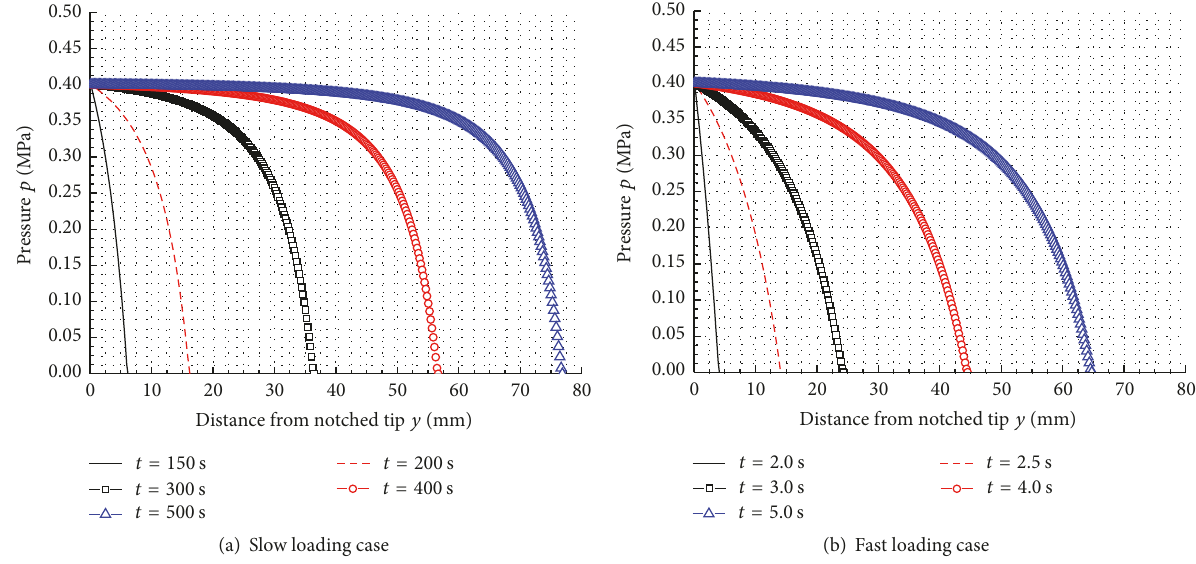
Figure 14: Water pressure distribution along a propagating crack surface.